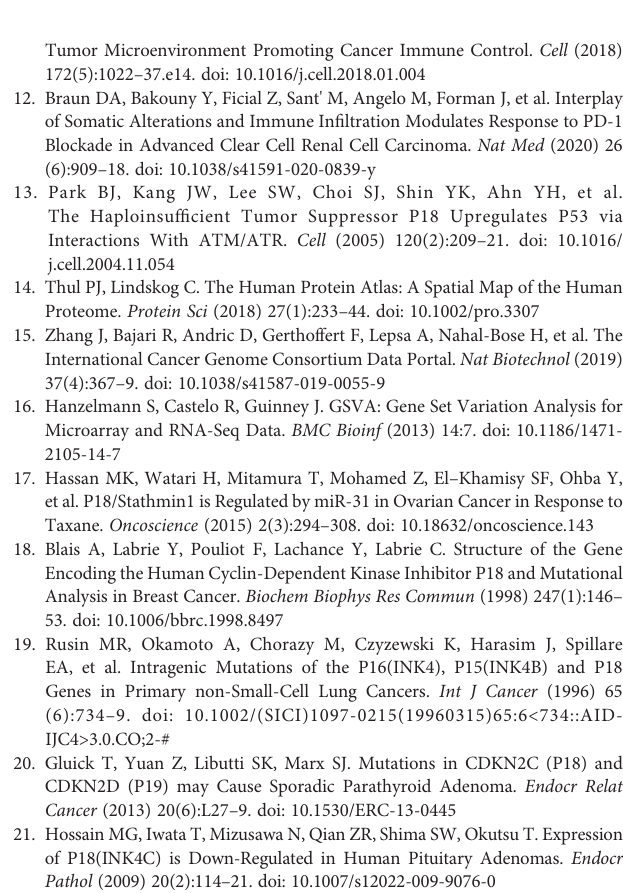
Supplementary Figure 1 | Validation of the expression patterns and prognosis signi fi cant of EEF1E mRNA and protein by use of third-party database. Supplementary Figure 2 | The expression of EEF1E1 in HCC was detected by IHC. Supplementary Figure 3 | The expression of EEF1E1 in HCC was detected by IHC(continued). Supplementary Figure 4 | The expression of EEF1E1 in HCC was detected by IHC(continued). Supplementary Figure 5 | The expression of EEF1E1 in HCC was detected by IHC(continued). Supplementary Figure 6 | The expression of EEF1E1 in HCC was detected by IHC(continued). Supplementary Figure 7 | The expression of ATM in HCC was detected by IHC. Supplementary Figure 8 | The expression of p53 in HCC was detected by IHC. Supplementary Figure 9 | The expression of CASPASE3 in HCC was detected by IHC. Supplementary Figure10 | Multiplex IHC detection the expression of CD3, CD4, CD8 and PD1 in HCC. Supplementary Figure11 | Multiplex IHC detection the expression of CD3, CD4, CD8 and PD1 in